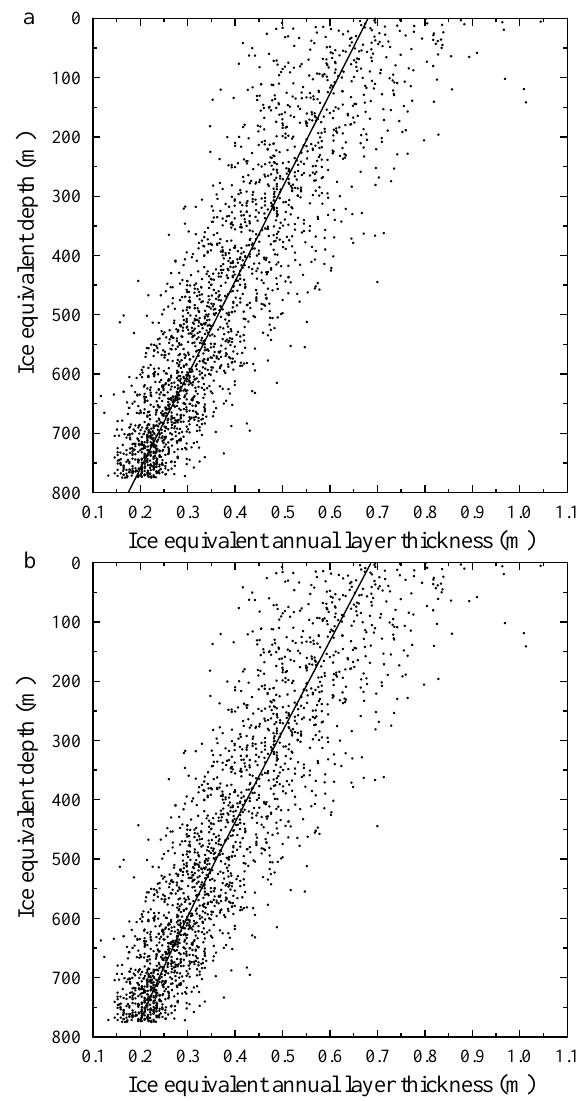
Figure 3. (a) Piece-wise linear fit to the annual layer thickness data and (b) power-law fit to the annual layer thickness data.